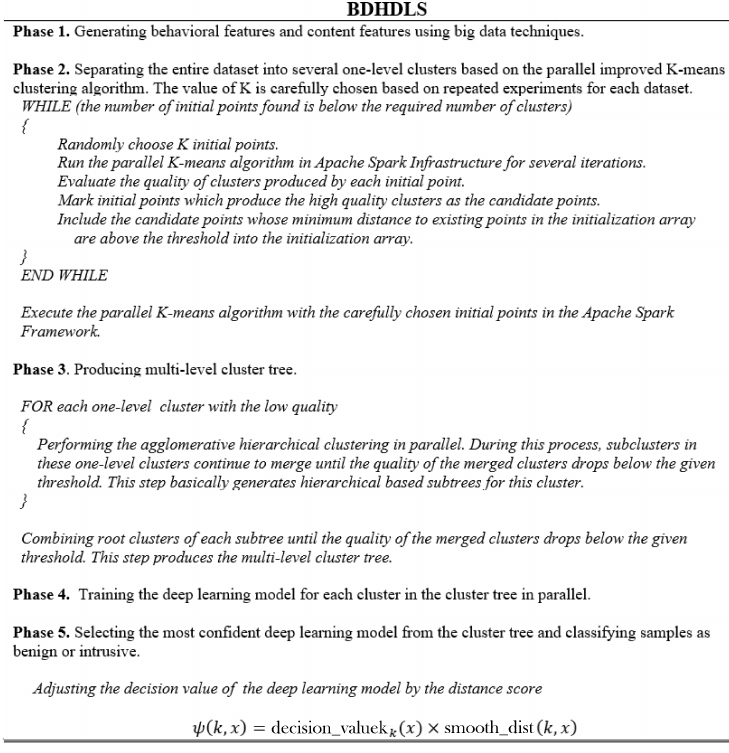
Fig. 5 Five phases of